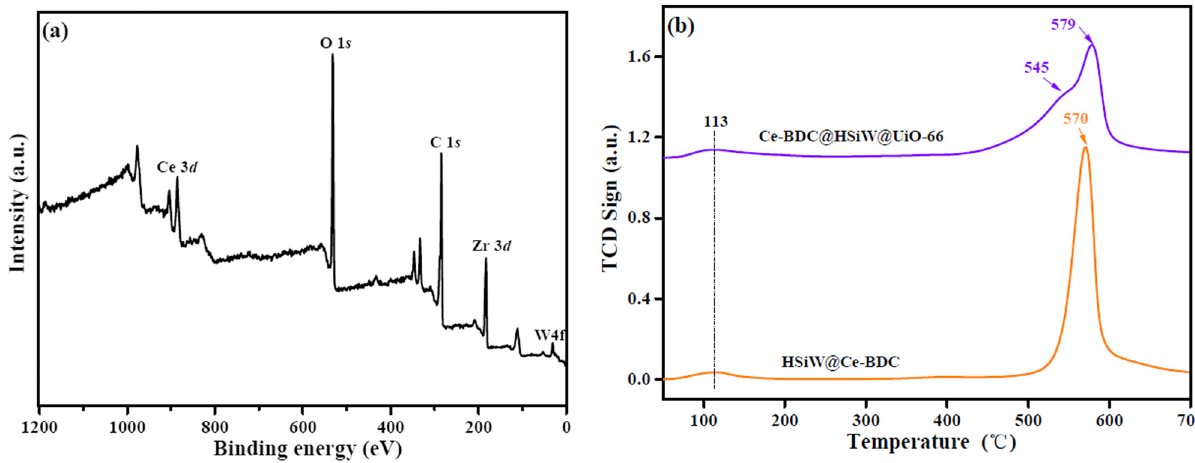
Figure 6: ( a ) XPS survey spectrum of Ce - BDC@HSiW@UiO - 66 hybrids; ( b ) NH 3 - TPD curves of HSiW@Ce - BDC and Ce - BDC@HSiW@UiO - 66 hybrids.